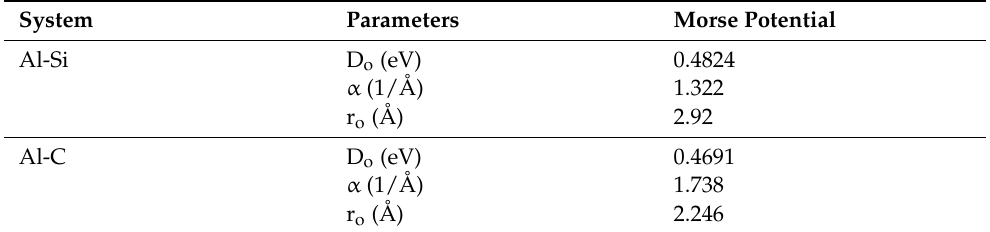
Table 3. Morse potential function parameters parameterized to the ab initio data obtained from Zhao et al.